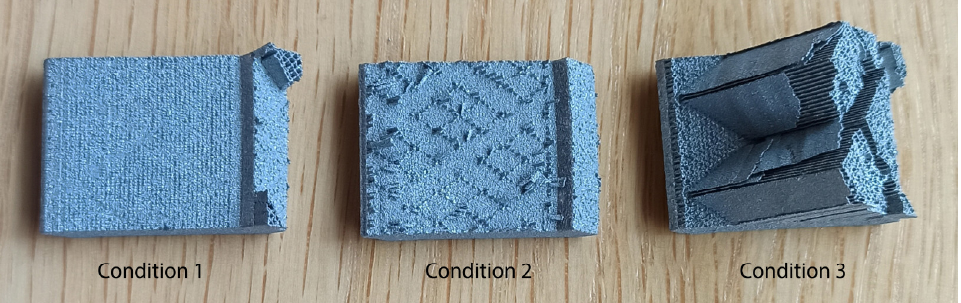
Figure 4. The 3 conditions to evaluate removability.